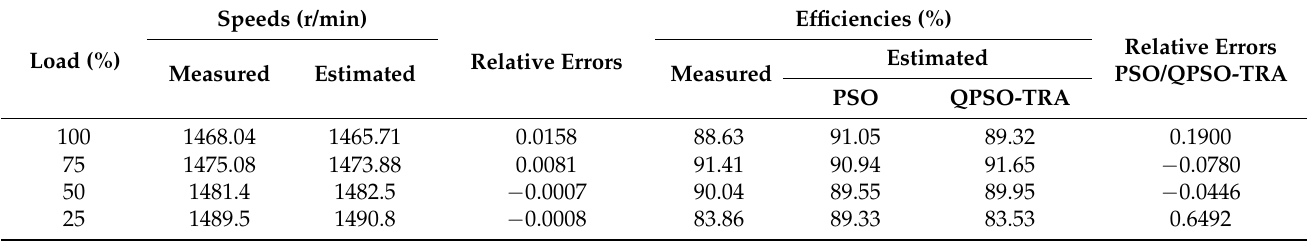
Table 4. 5.5 kW motor estimated efficiencies and speeds versus measured in the